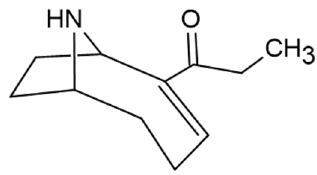
Figure 5. Homoanatoxin-a.